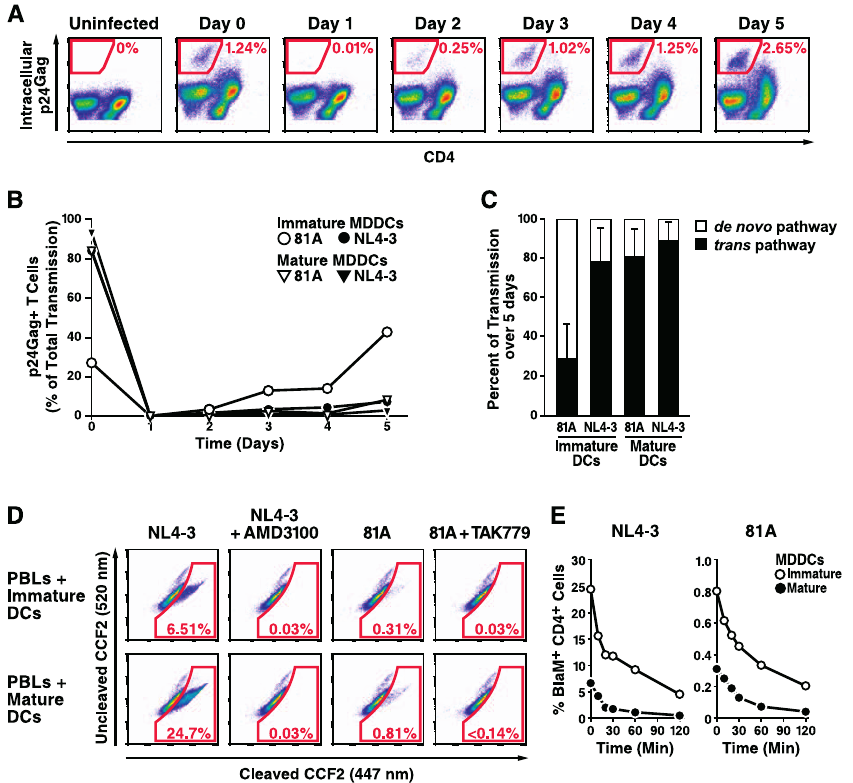
Figure 1. Mature MDDCs Transmit HIV-1 to T Cells Primarily via the trans Pathway (A–C) NL4–3 or 81A virions were bound to MDDCs. After washing, the cells were added to activated autologous T cells immediately or after 1 to 5 d of culture at 37 8 C to allow HIV-1 transmission to T cells for 24 h. The number of transmission events was measured by monitoring the appearance of infected T cells detected by p24 Gag intracellular immunostaining. (A) Transmission of 81A virions from immature MDDCs to T cells over time. FACS plots represent the population of T cells (CD3 þ CD1a – ) analyzed for intracellular Gag and CD4 expression. (B) Effects of maturation on HIV-1 transmission from MDDCs to T cells. Values are percentages of all transmission events over 5 d. (C) Relative contribution of trans pathway or de novo pathway in transmission of virus from immature or mature MDDCs to T cells. Data are averaged from MDDCs derived from nine donors. Transmission events from days 1 to 5 were added to determine the number of transmission events occurring via the de novo pathway. (D and E) NL4–3 or 81A virions containing BlaM-Vpr were bound to MDDCs at 4 8 C. After washing, the cells were added to autologous T cells immediately (T (D) HIV-1 transmission from MDDCs to T cells at T 0 . FACS plots show CD3 þ CD4 þ CD1a – cells analyzed for virion fusion. To control for specificity, MDDCs were incubated with T cells and entry inhibitors (500 nM TAK-779 or 500 nM AMD3100). (E) Effect of time on NL4–3 and 81A transmission from MDDCs to T cells. The curve is representative of four experiments.